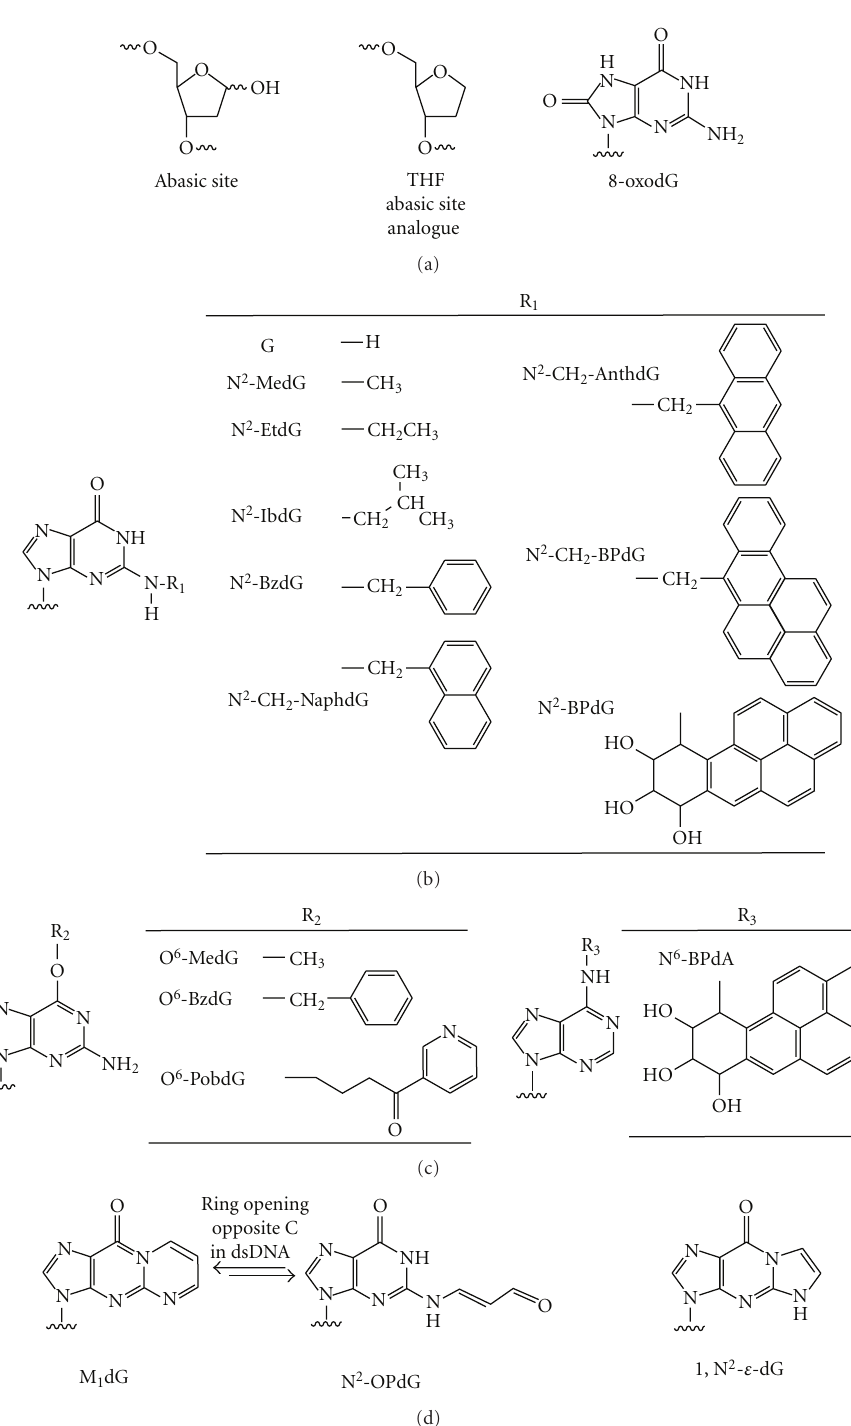
Figure 1: Overview of DNA adducts. The number of DNA adducts formed through interactions with reactive chemicals or ionizing radiation is vast, and more thorough reviews have been performed elsewhere [7]. We have chosen to focus on some of the most thoroughly studied DNA adducts, in terms of how the adduct a ff ects DNA polymerase structure and function. A, abasic sites and 8-oxodG; B, minor groove N 2 -dG adducts; C, major groove O 6 -dG and N 6 -dA adducts; D, exocyclic dG adducts. Adduct stereospecificity is not shown in structures of of B[ a ]P DNA